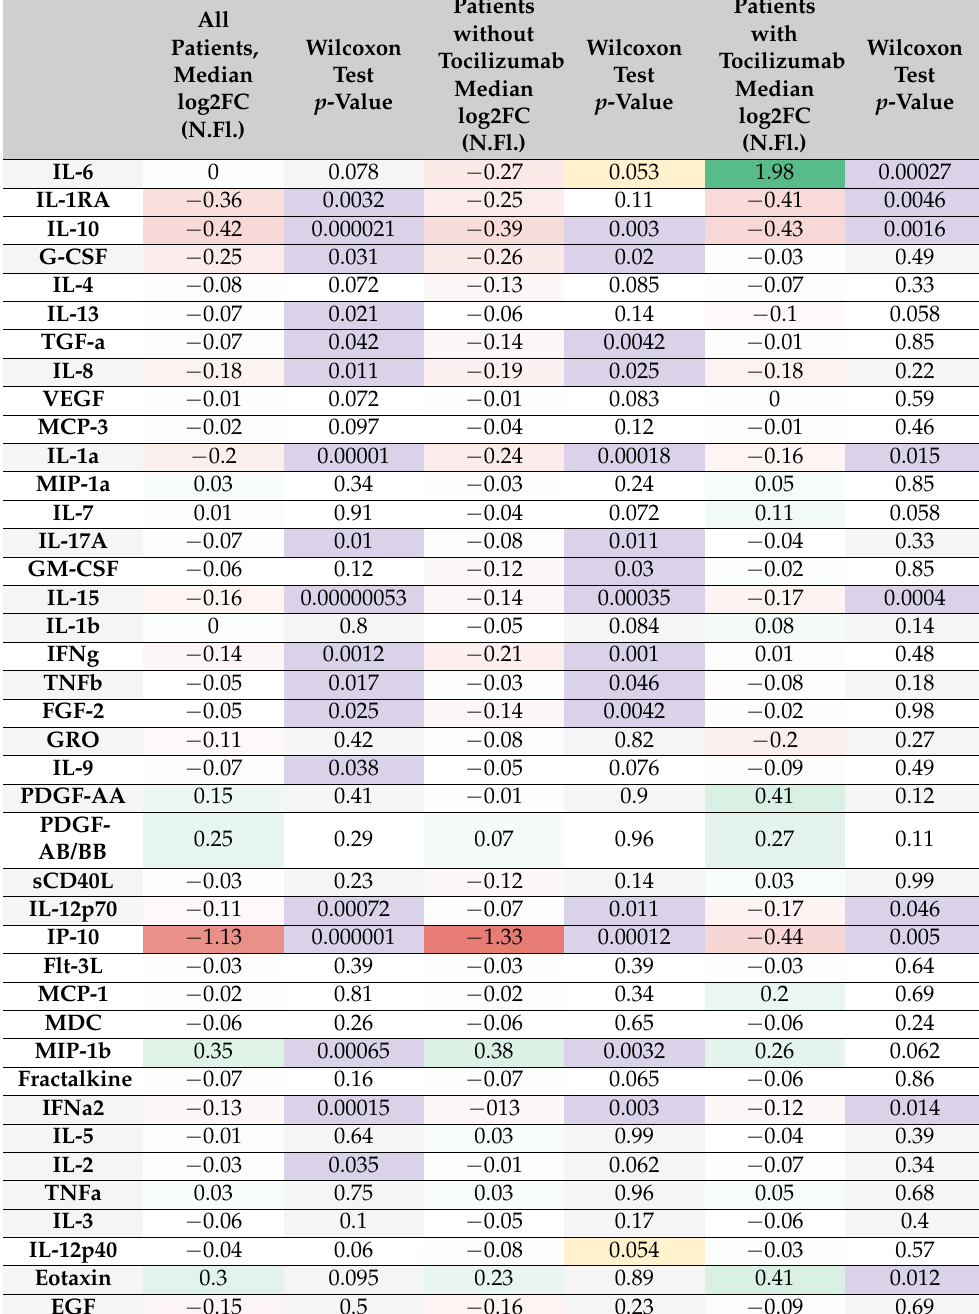
Table 8. Dynamic changes in cytokine concentrations after the treatment. Data are presented as the median of log2 of the change in the normalized fluorescence intensity values. p -values are presented according to the Wilcoxon